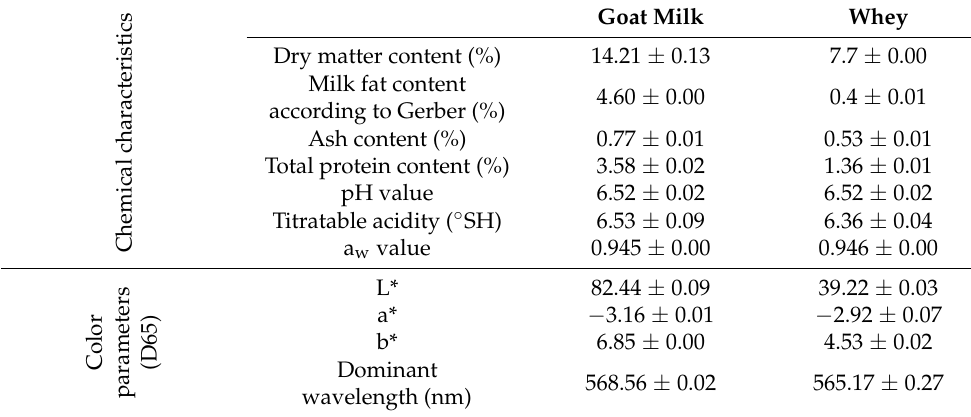
Table 1. Physico-chemical parameters of goat’s milk and